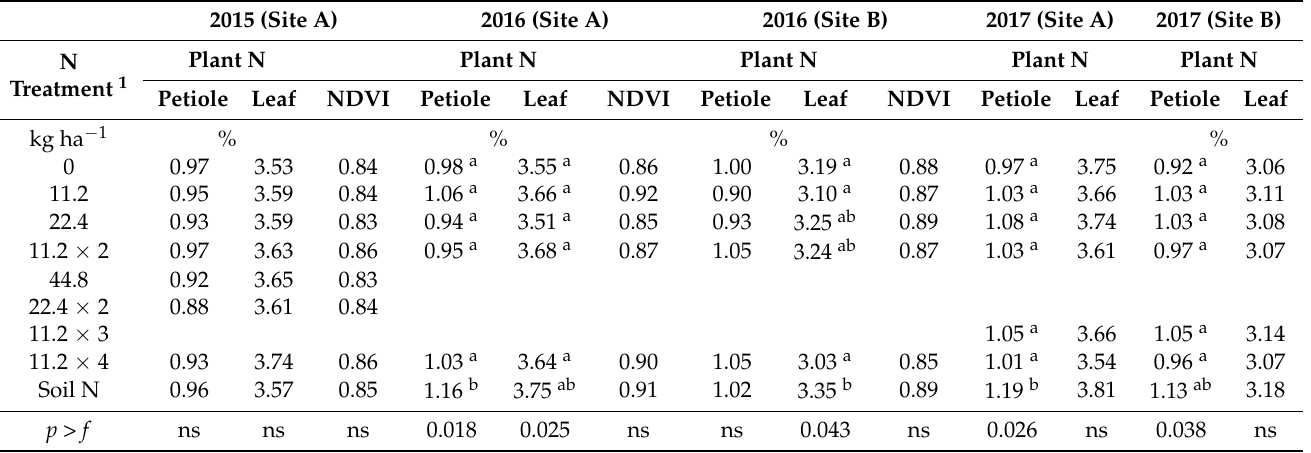
(Table 3). In 2017, soil applied N at both sites slightly but significantly increased petiole N, but no difference was observed in leaf N (Table 3). Compared to 2015, where a lower N rate was soil applied, the plant N data illustrate that soil N applied at relatively high rates may only slightly increase plant N content at full bloom. Table 3. Foliar and soil applied N effects on plant N and NDVI at full bloom 1